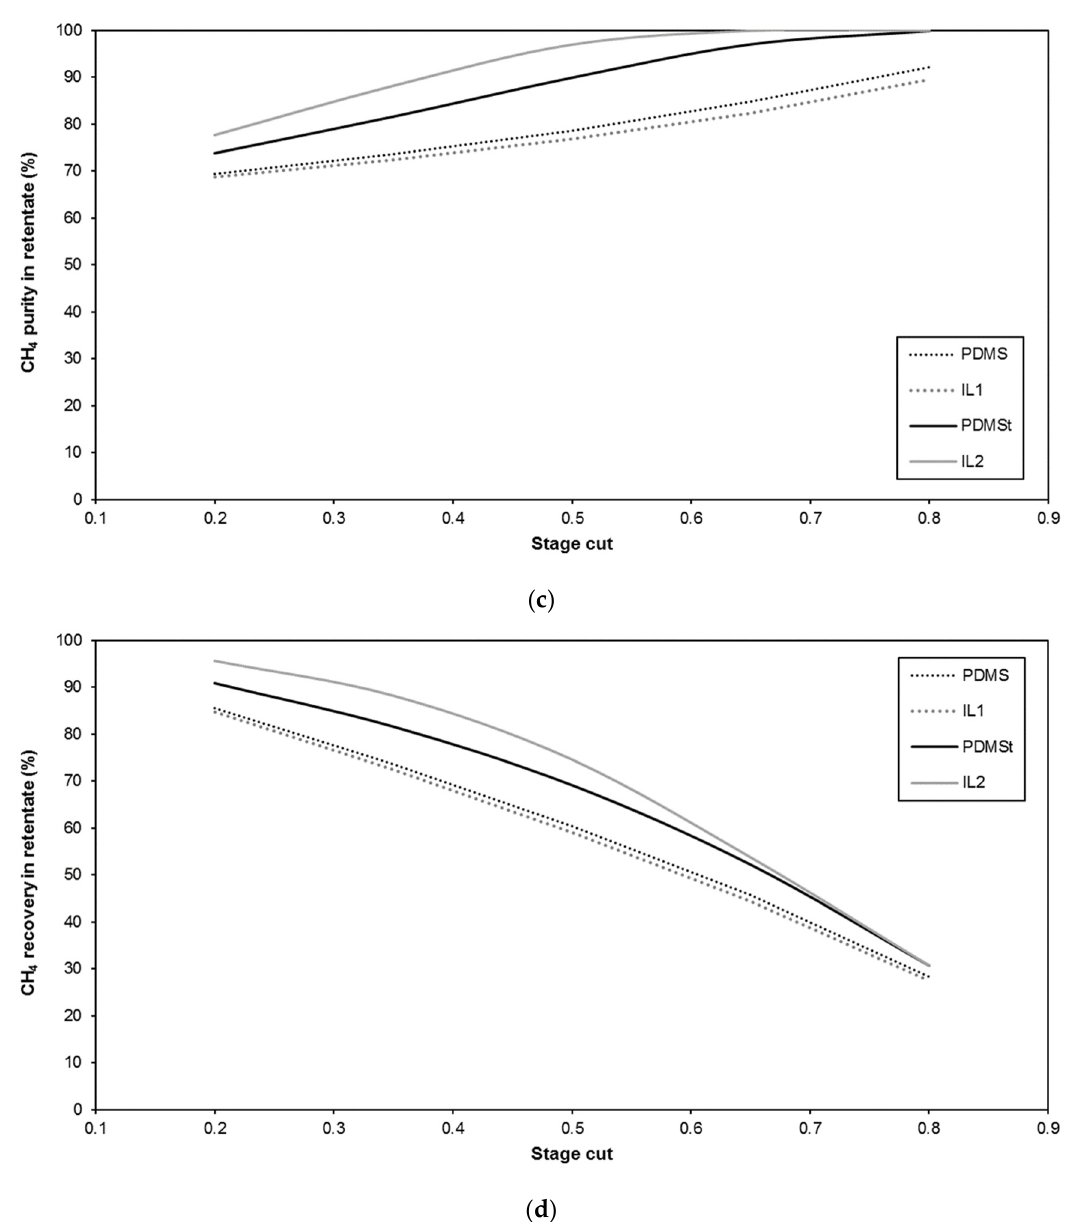
Figure 5. Influence of the stage cut on ( a ) CO 2 purity, ( b ) CO 2 recovery, ( c ) CH 4 purity and ( d ) CH 4 recovery for the different membranes (P F = 4 atm, P Q = 1 atm, CO 2 /CH 4 feed composition = 0.35/0.65).